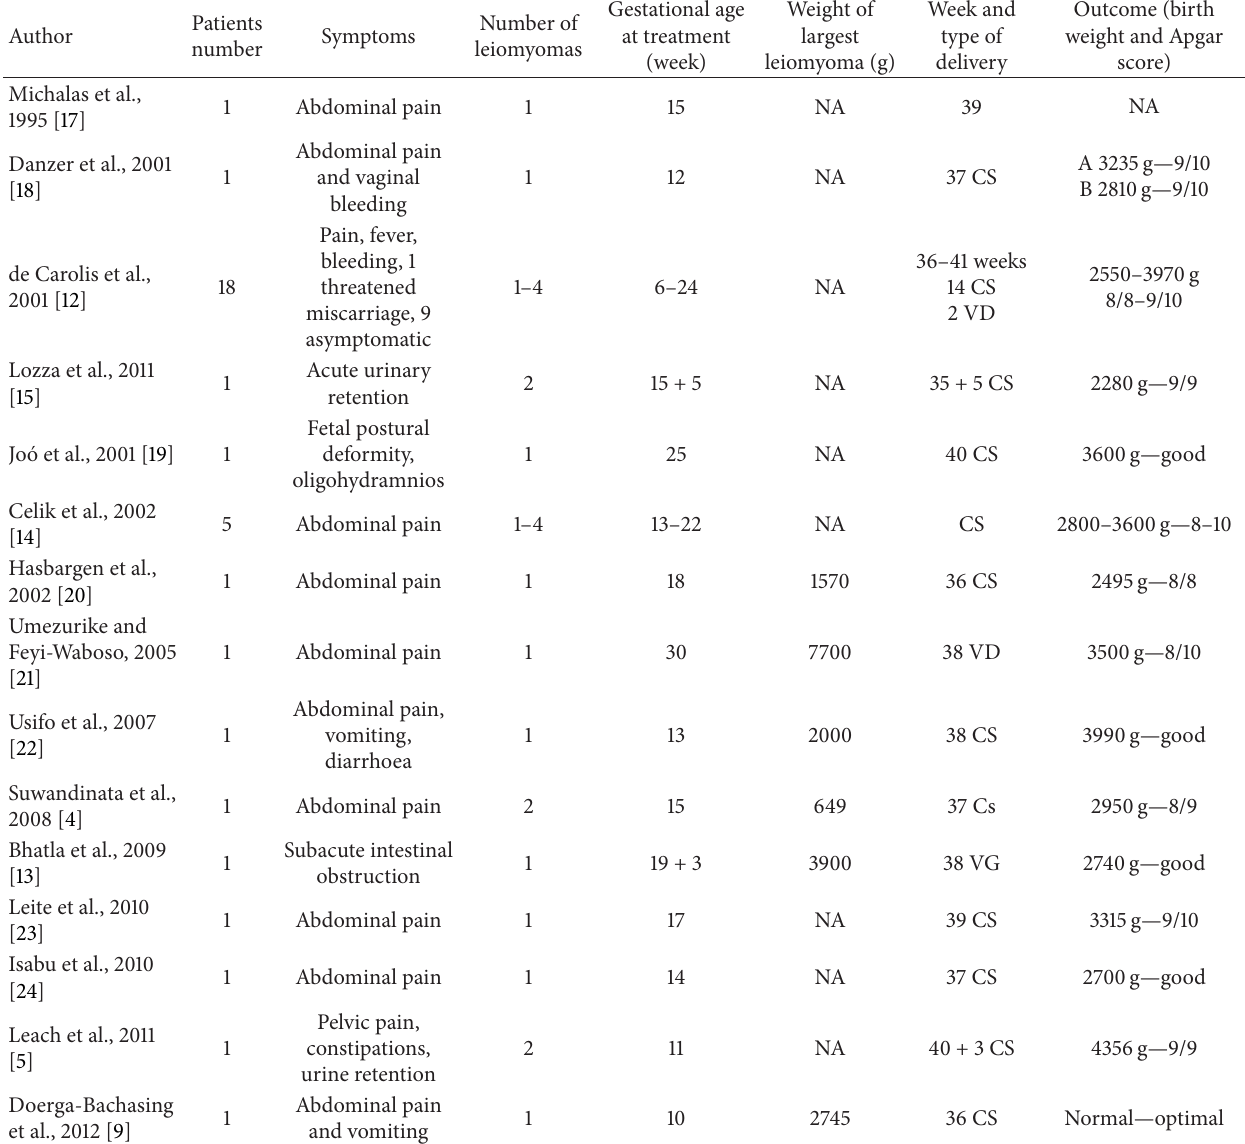
Table 1: Case reports, case series, and a literature